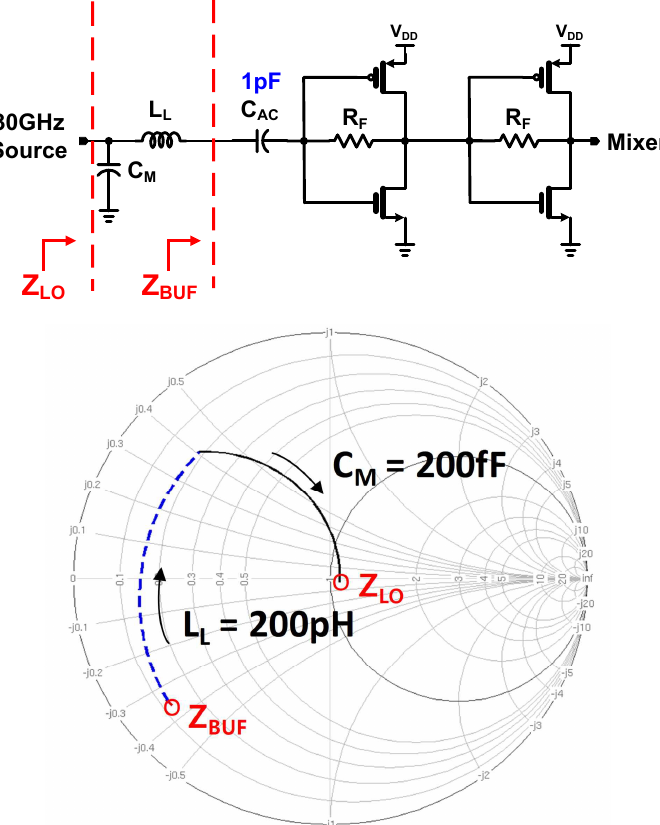
Figure 10. Schema of the two-stage LO buffer with reactive matching and a Smith chart with the trajectory from Z BUF to the 50 Ω .